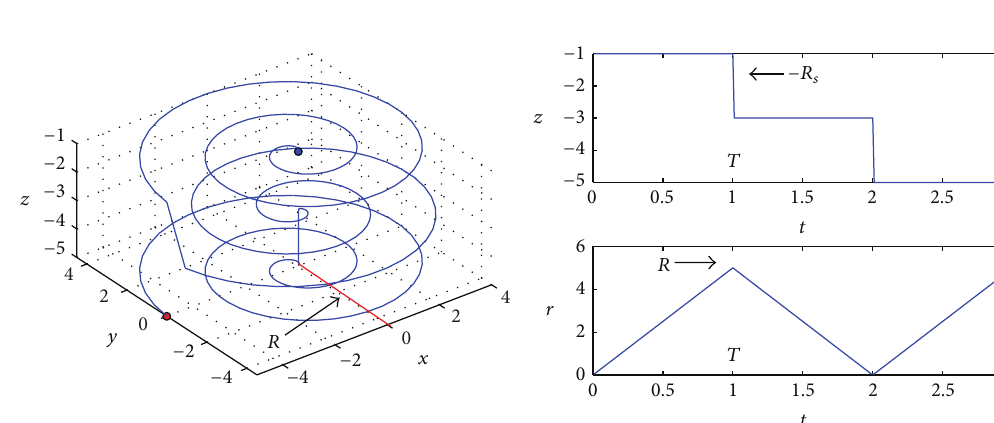
Figure 2: Helix curve.